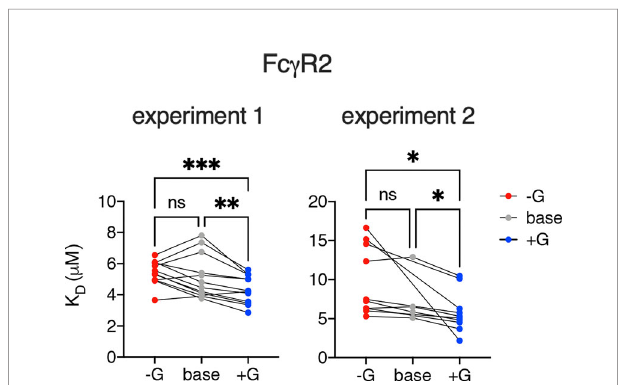
FIGURE 4 | Increased galactosylation is associated with improved af fi nity for Fc g RII. The effect of increased and decreased galactose content on binding to Fc g RII variants among IgG Fc glycotypes for which other glycan characteristics (e.g., fucosylation, sialylation, bisection) were held constant. Statistically signi fi cant differences were tested using a mixed effect model with Tukey ’ s test of multiple comparisons (*p < 0.05, **p < 0.01, ***p < 0.001). ns, not signi fi